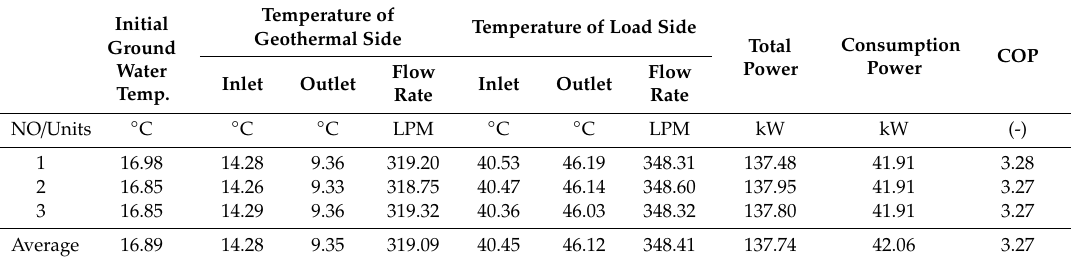
Table 6. Measured results of the BW SCW geothermal system during heating operation.